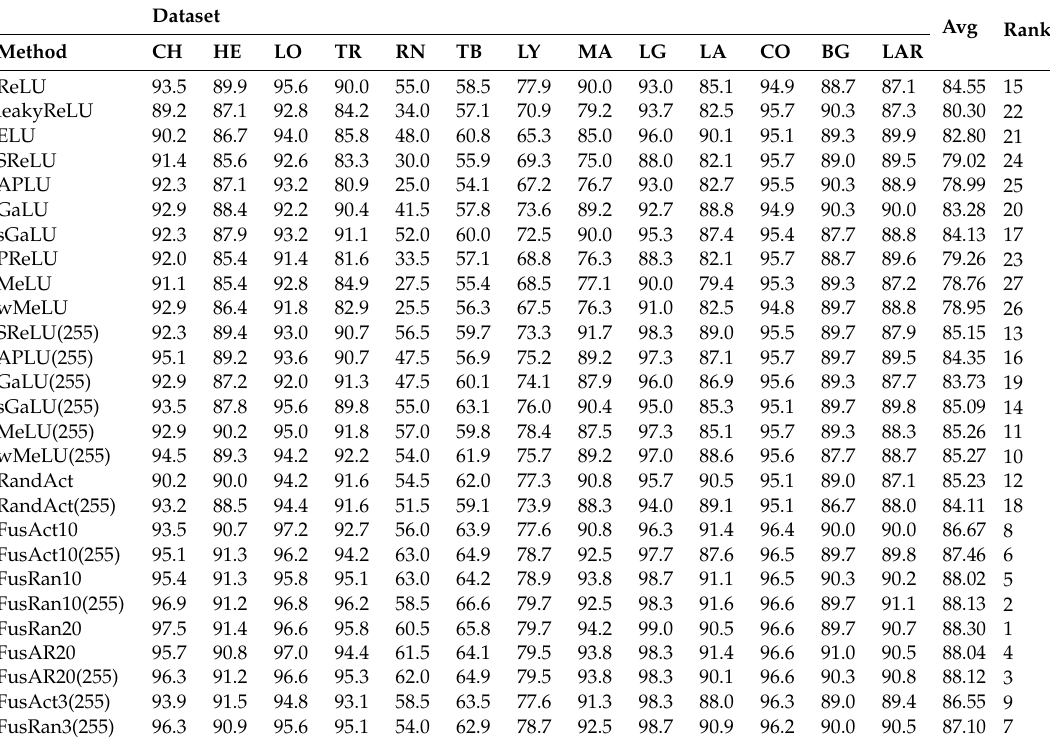
Table 5. Performance of the proposed approaches in the medical image datasets (accuracy).